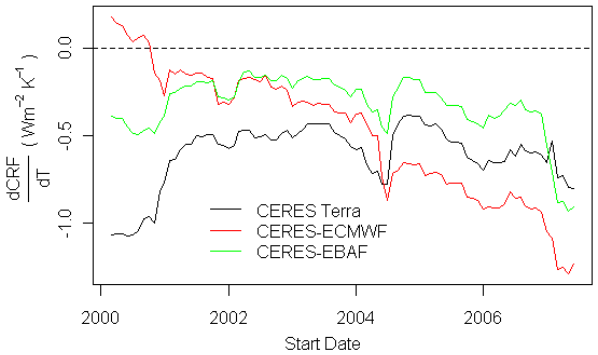
dTdCRF d T to different start dates (all regressions end in 6/2011), 2